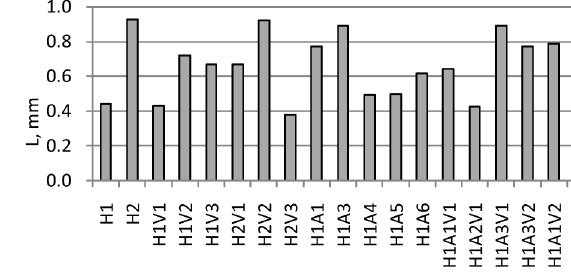
Fig. 2. The air-void spacing factor of HPSCC (Łaźniewska- Piekarczyk 2013)